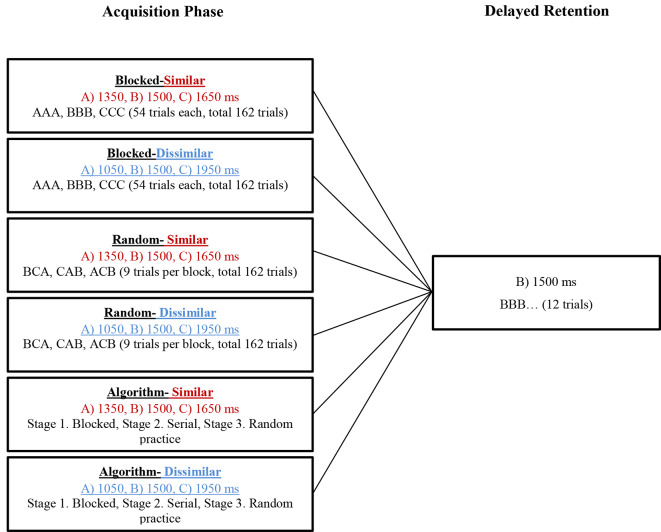
The paradigm of the experimental groups in the acquisition phase and delayed retention. Note that algorithm practice was a combination of blocked, serial, and random practice that forward and/or not backward switching between stages was based on error rate (number of error trial ≤33% in each block based on error range of the ATGs, ±5%).